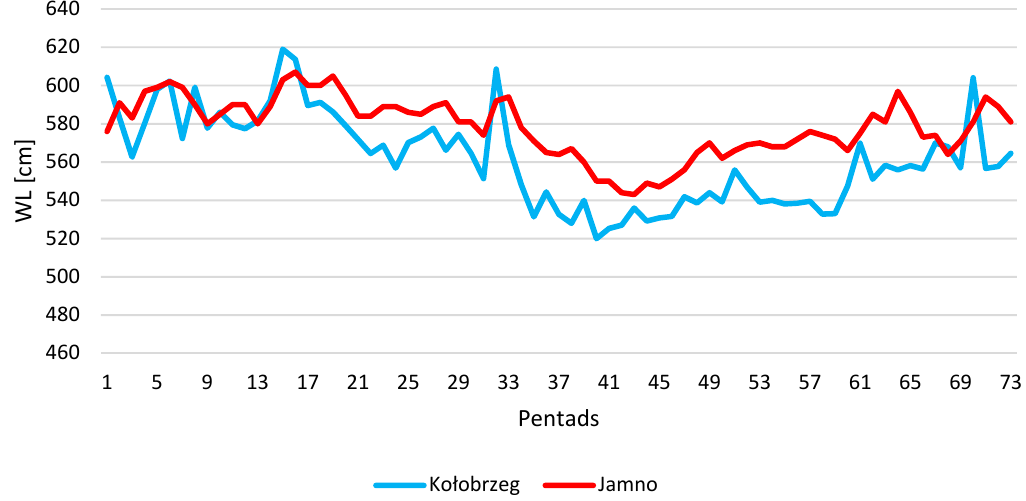
Figure 6. Course of maximum pentad water levels in Lake Jamno and the Baltic Sea at station Ko ł obrzeg.